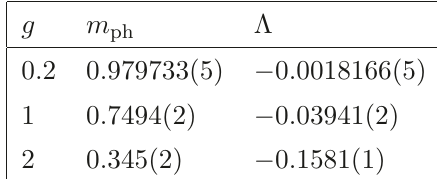
Table 1 . m ph and Λ extracted with